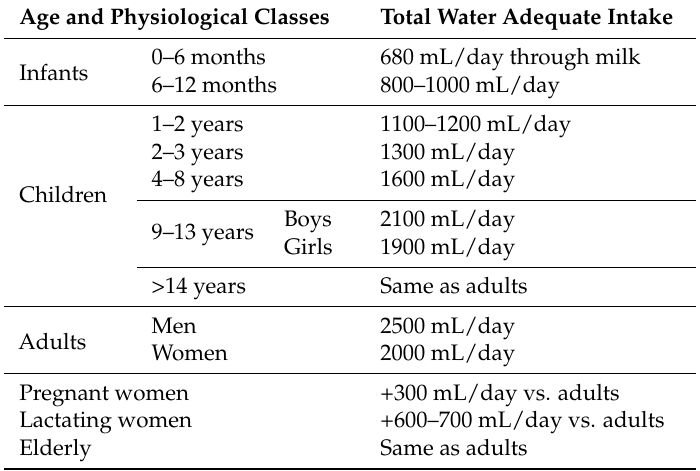
Table 1. Dietary reference intakes (adequate intakes) for total water set by the European Food Safety Authority (EFSA) [5].